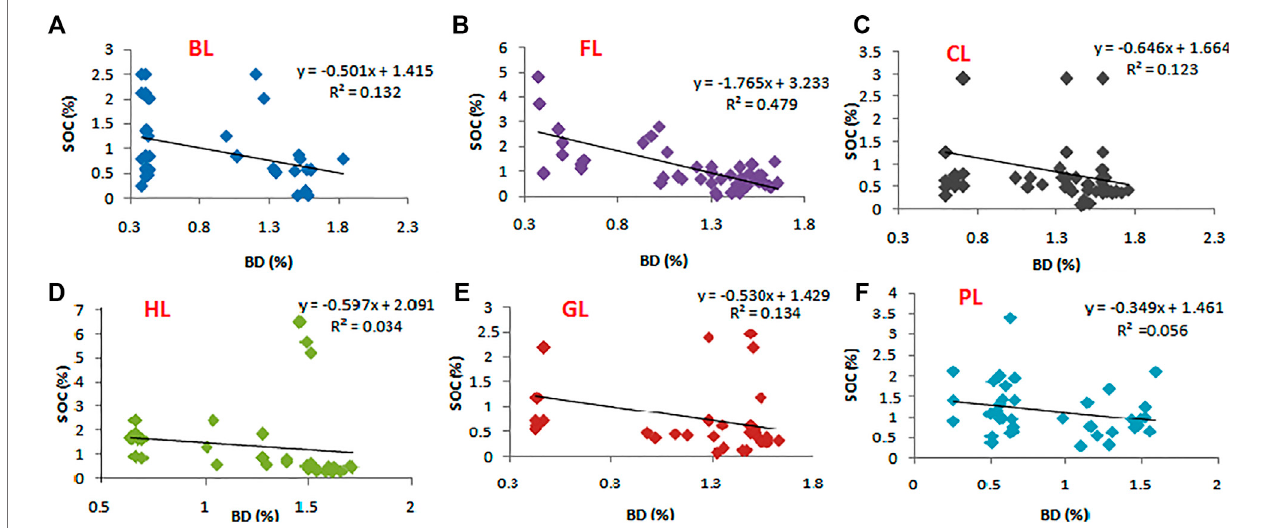
FIGURE8| Linearregressionwiththevariables ofsoilorganic carbon (SOC)and bulkdensity (BD)incontrastwithsixdifferentlanduses, withsigni fi cantdifference in R 2 value at p < 0.05. Here, FL, Forest land; BL, Barren land; CL, Cultivated land; GL, Grassland; HL, Horticulture land; PL, Plantation land.